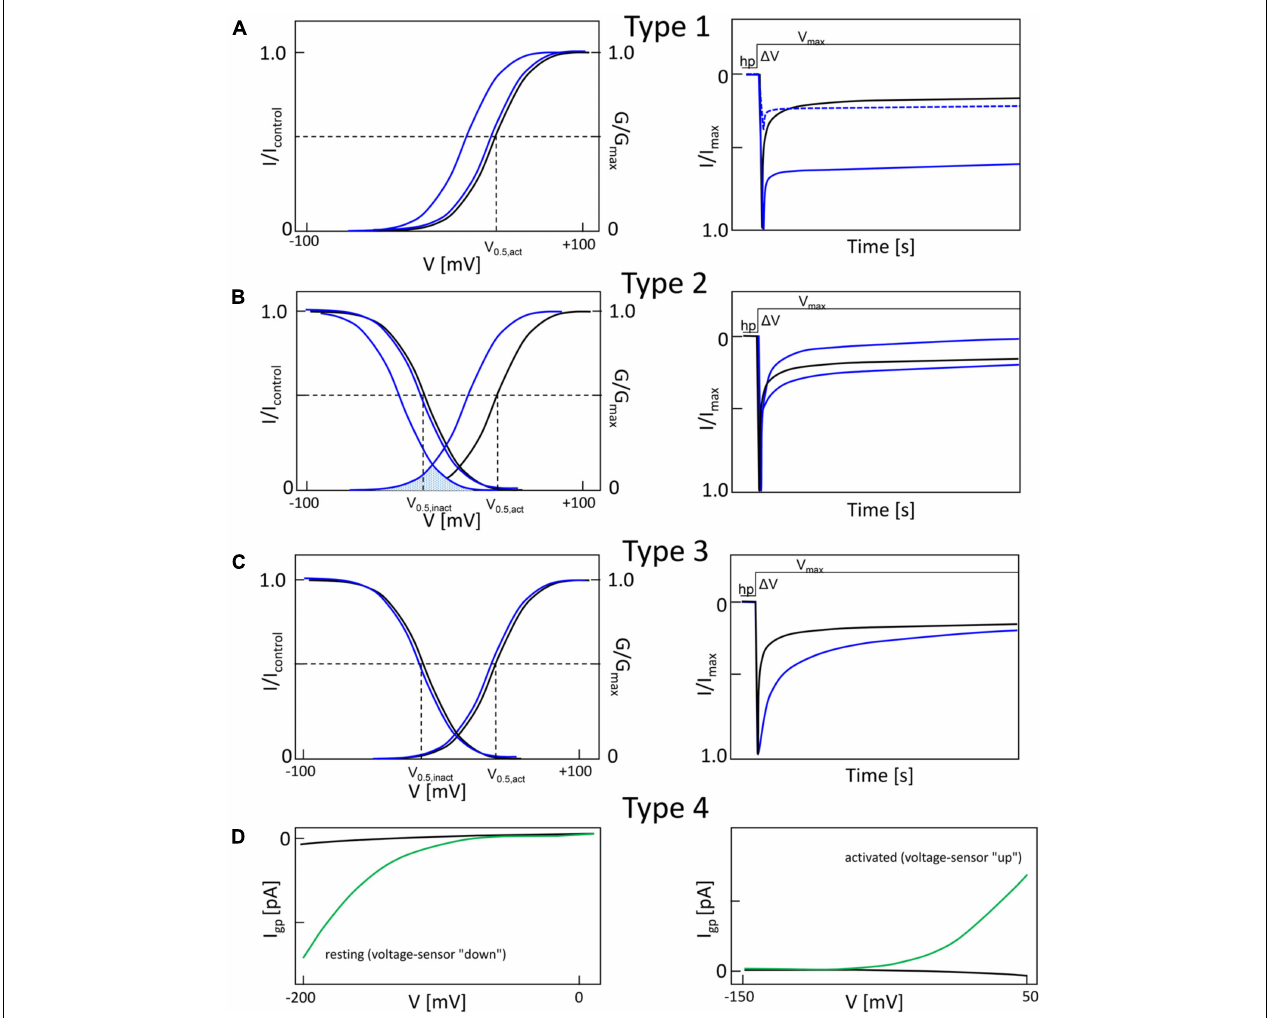
FIGURE 2 | Typical gain-of-function macroscopic gating changes described for inherited or de novo missense mutations in voltage-gated Ca 2 + channel α 1-subunits. To facilitate discussion the most frequently observed gating changes are classified into types 1-4. For details see text. Mutant current properties are indicated in blue (A–C) or green curves (D) , wildtype current in black. (A) Type 1 is characterized by the appearance of a large fraction of a non-inactivating current component (as e.g., during long depolarizations from a negative holding potential to the potential of maximal inward current; right panel). Changes in the voltage-dependence of activation gating (left) may or may not be present (blue curves, left). Note that even if maximal inward current is reduced by a mutation, current amplitude may exceed wildtype current later during depolarization due to the slowly inactivating current component (right, dotted curve). (B) The main feature of type 2 changes is a strong shift of the voltage-dependence of activation to more negative voltages independent of smaller effects on current inactivation during depolarizations. The voltage-dependence of inactivation may or may not be shifted to more negative voltages (left). The voltage range in which steady-state inward current (“window current”) may be observed (i.e., the overlap of voltage-dependence of activation and inactivation curves) is indicated for mutant current (shaded) (C) . Some mutations do not affect the voltage-dependence of gating (left) but cause a slowing of inactivation (weaker than in type 1). (D) As described in Figure 5 , gating pore currents are enabled by mutations of an S4 gating charge (green lines). The position of the mutation relative to the hydrophobic constriction site (HCS, Figure 5 ) determines if the pore is open during the hyperpolarized “down”-state of the S4 helix at negative voltages (left) or during the depolarized “up”-state at positive voltages (right). In the “down” state, at potentials near the K + -equilibrium potential, inward gating-pore currents would be primarily carried by Na + . In the “up” state, at potentials positive to the activation threshold of the channel, potassium outward gating-pore current predominates. However, upon fast repolarization of the action potential to negative potentials Na + inward gating-pore current may predominate until the voltage sensor moves back to the “down” position” (especially relevant in “slowly inactivated” Na + -channels,” for details see ref. Sokolov et al., 2008). G/G max , normalized conductance (steady-state activation); I/I max , normalized inward current (steady-state inactivation). V 0 . 5 , act , V 0 . 5 , inact , half maximal voltages of activation and inactivation; hp, holding potential; (cid:49) V, depolarization from a negative holding potential to the voltage of maximal inward current (V max